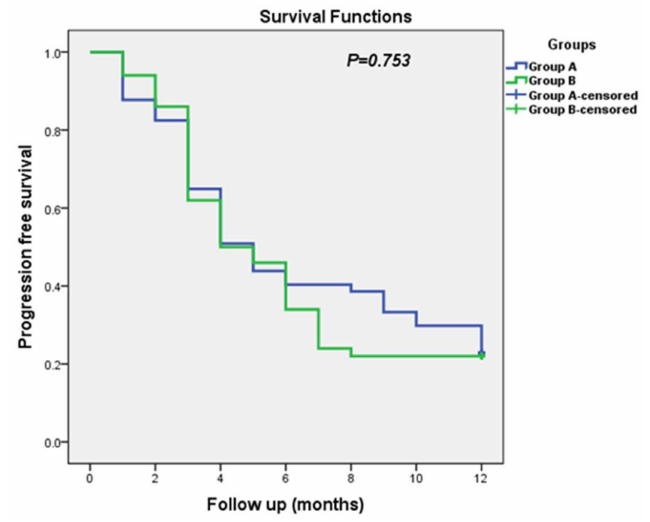
Figure 5. Kaplan–Meier curves for progression free survival among both studied